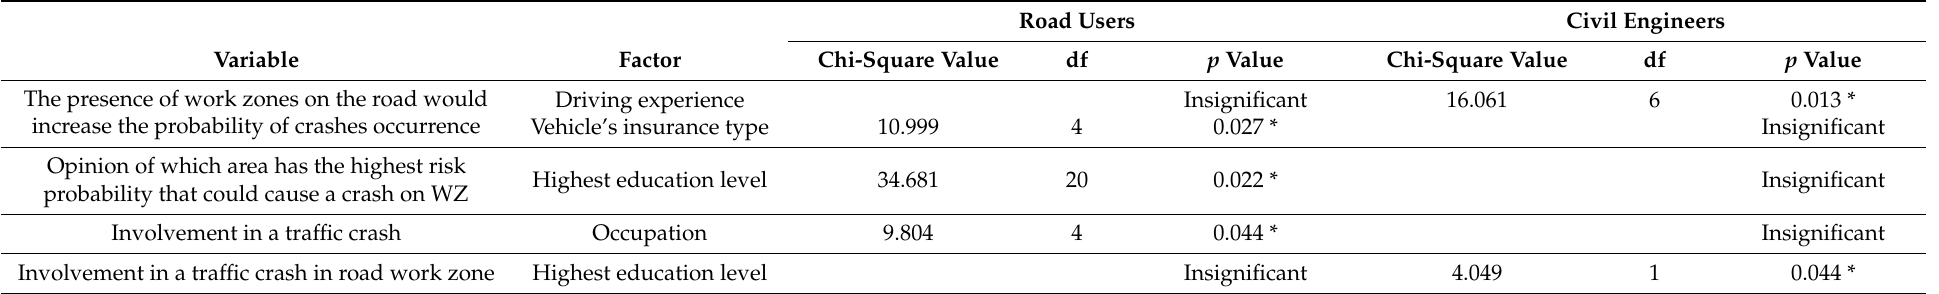
Table 3. Association between the observed